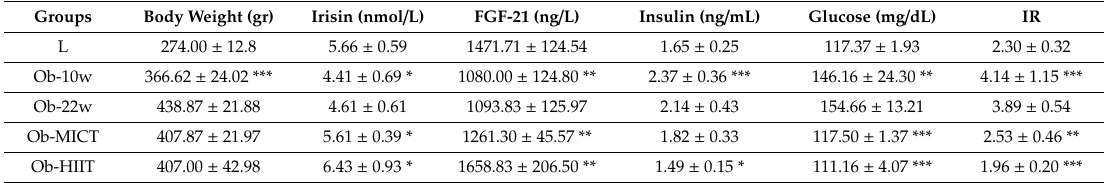
Table 1. E ff ect of obesity and exercise training on body weight, plasma irisin, fibroblast growth factor (FGF)-21, glucose, and insulin.